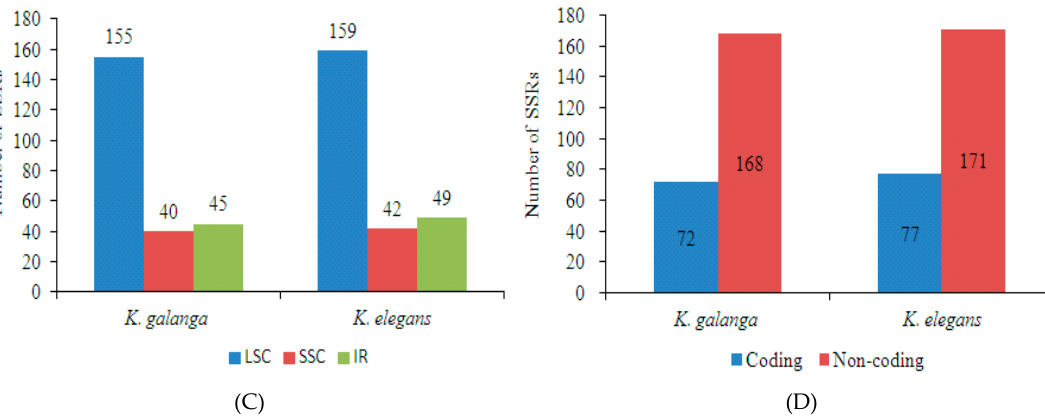
Figure 3. Distribution of SSRs in the chloroplast genomes of K. galanga and K. elegans . ( A ) Number of different SSR types detected in the two Kaempferia species chloroplast genomes; ( B ) Frequency of identified SSR motifs in different repeat class types; ( C ) SSR distribution in different genomic regions of two Kaempferia species chloroplast genomes; ( D ) SSR distribution between coding and non-coding regions of two Kaempferia species chloroplast genomes.